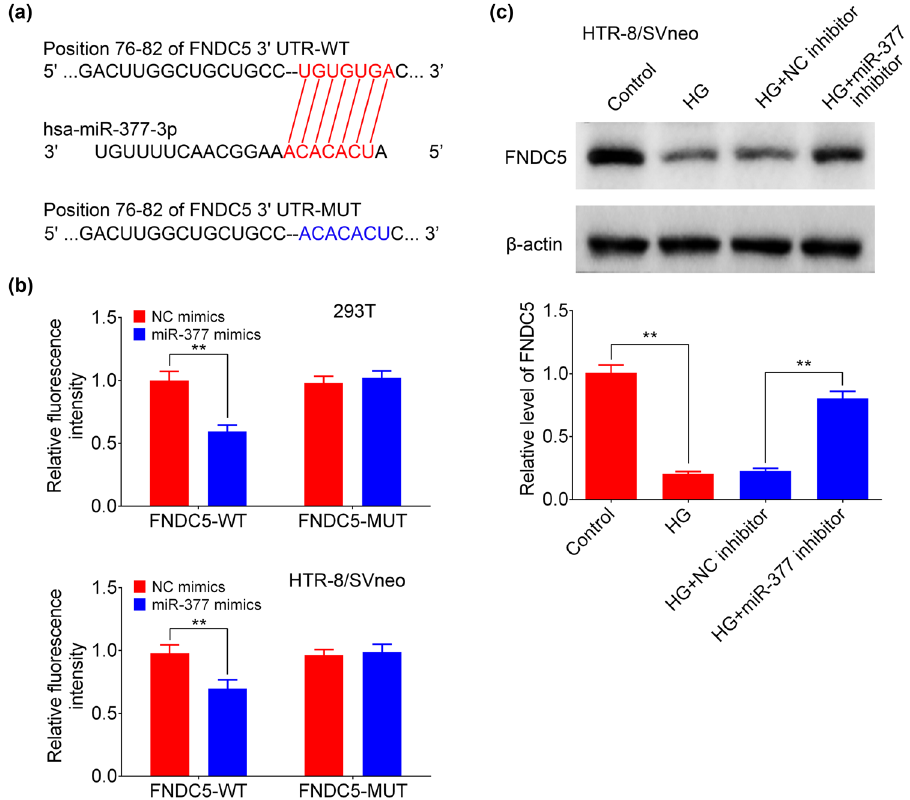
Figure 4: miR - 377 - 3p negatively regulated FNDC5 expression. ( a ) The predicted seed - recognition sites in the 3 ′ - UTR of FNDC5 mRNA and the miR - 377 - 3p sequences were shown. ( b ) Relative luciferase activity of the FNDC5 3 ′ - UTR reporter plasmid in 293 T and HTR - 8/SVneo cells after transfection with NC mimic or miR - 377 - 3p mimic. The mutant FNDC5 3 ′ - UTR reporter was also used as a control. ( c ) Protein expression levels of FNDC5 in HTR - 8/SVneo and BeWo cells from groups of control, HG, HG + NC inhibitor, HG + miR - 377 - 3p inhibitor, HG + NC mimic, HG + miR - 377 - 3p mimic, as determined using western blotting. Bands were quanti fi ed and shown in histogram. The data are expressed as mean ± SEM. ** indicates p <